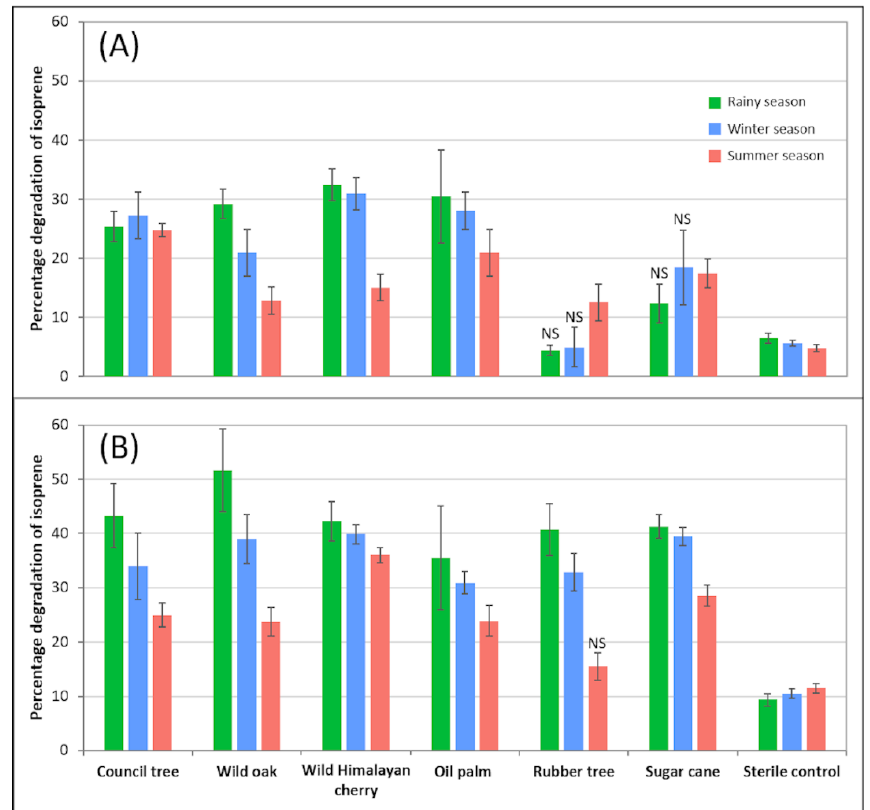
Figure 1. Percentage loss of isoprene over 96 h in microcosms containing 1 g of soil, incubated with isoprene at two different concentrations: ( A ) 7.2 × 10 5 ppbv and ( B ) 7.2 × 10 6 ppbv. n = 5. Error bars show ±SE. NS = the percentage loss was not statistically different from the sterile control (Anova; p < 0.05).